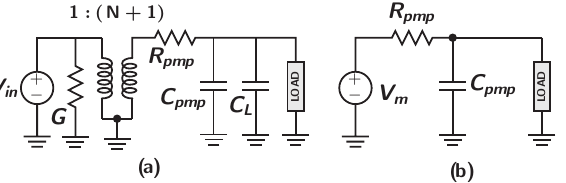
Figure 2. Various models of DCP: ( a ) Transformer model [15,16]; ( b ) RC model